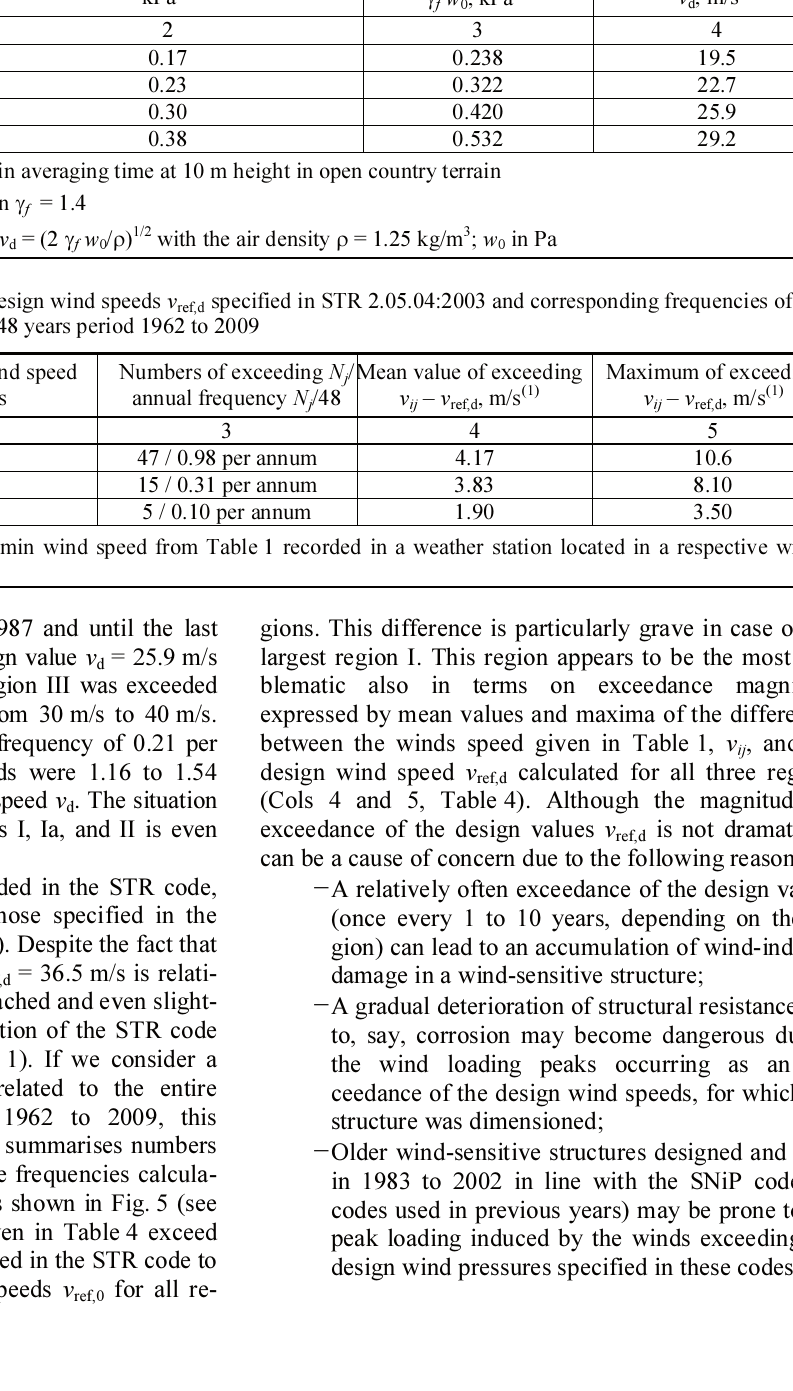
Table 3. Wind speed regions specified in the structural design code SNiP 2.01.07-85 used in Lithuania in the years 1987 to 2002 Wind speed region